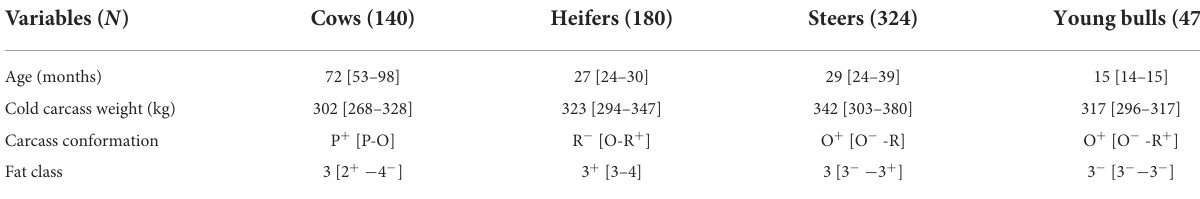
TABLE 1 The median [p25–75] age, cold carcass weight, carcass conformation and fat classification score for each category of cattle included in the Dungannon abattoir dataset excluding mature bulls ( N = 691).